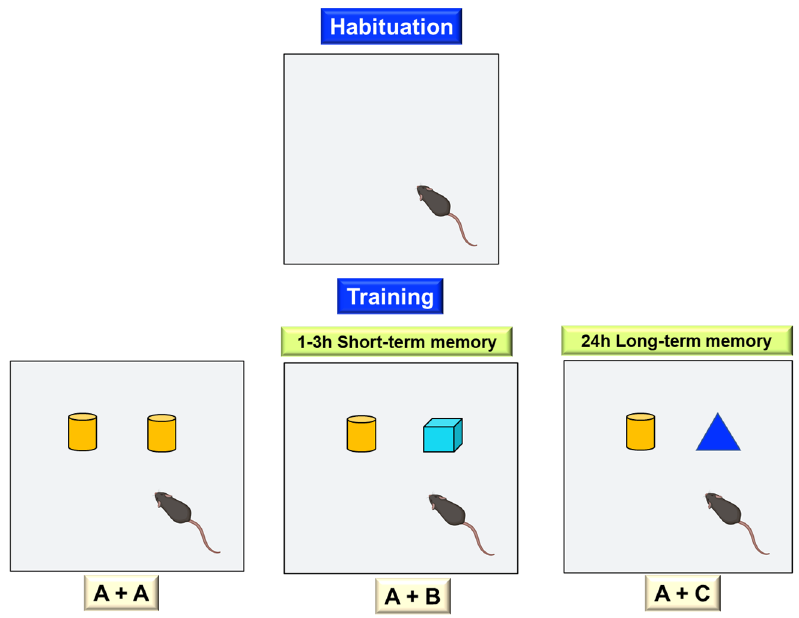
Figure 5. Object recognition test. The experimenter can study short- and long-term memory by modifying the time interval between the first exposure to two identical objects and the following exposures, in which the degree of exploration of the familiar object is compared to a new one.